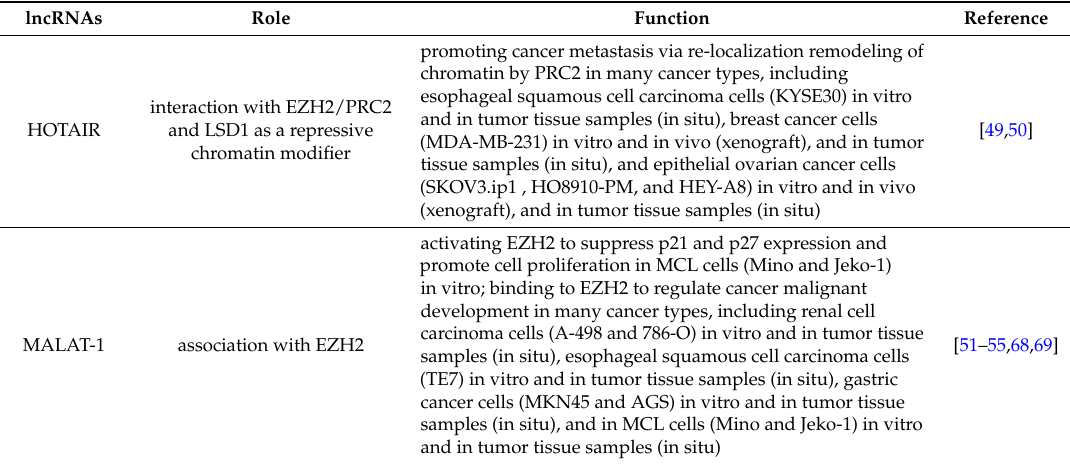
Table 3. The lncRNAs associated with EZH2 and their